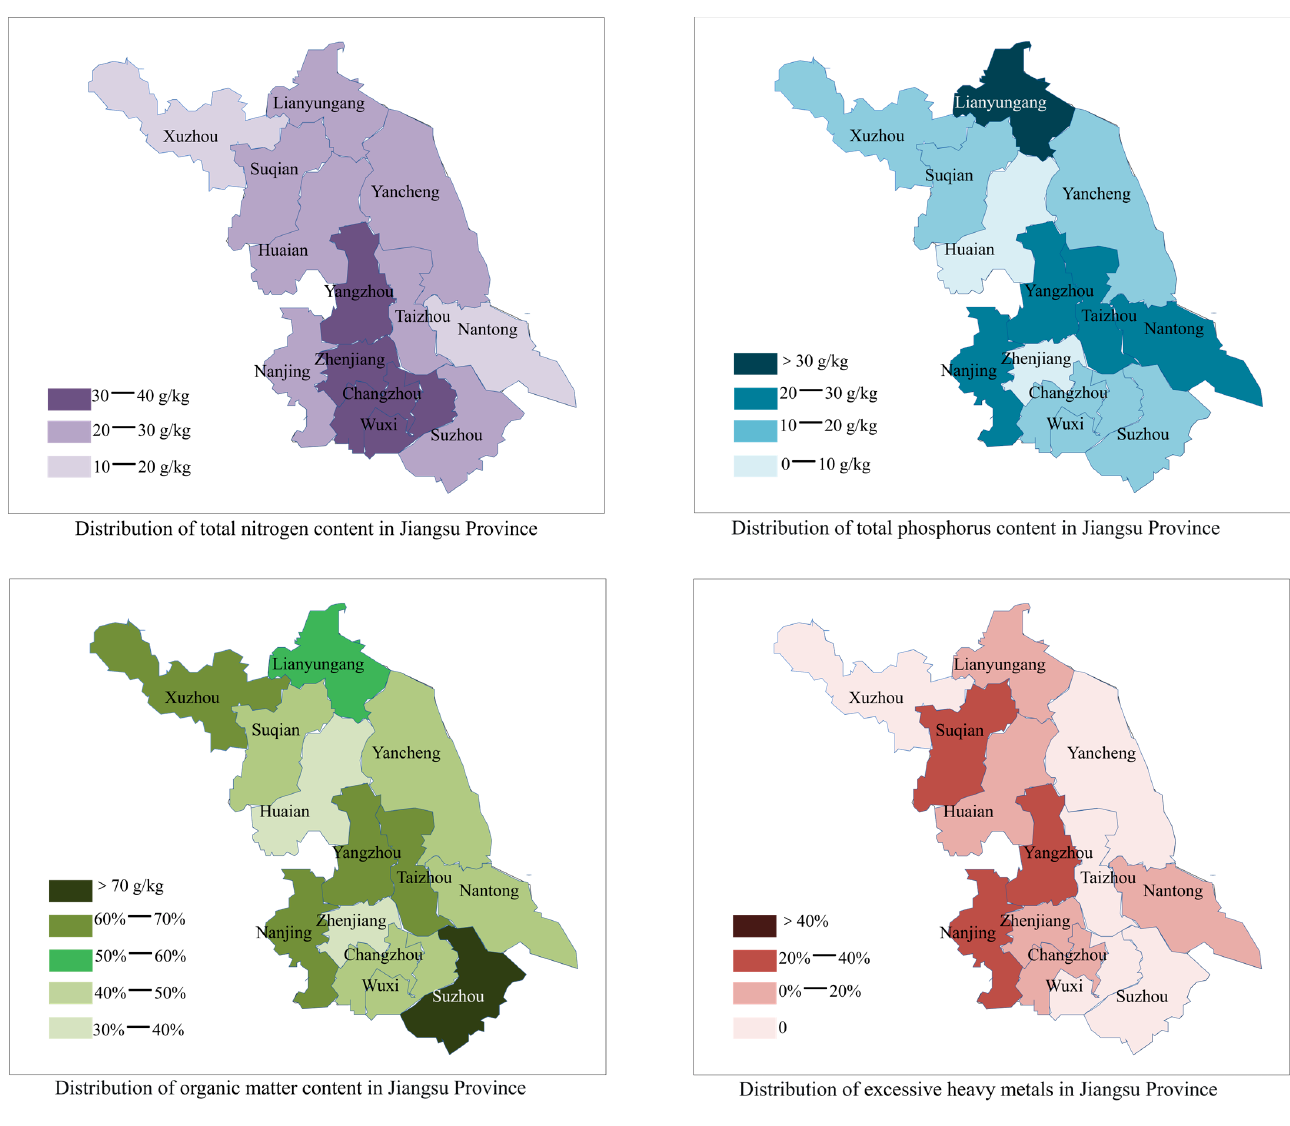
Figure 2. Geographical distribution of total nitrogen, total phosphorus, organic matter and heavy metal exceedances in sewage sludge in Jiangsu Province. Table 3. Pollutant content in different regions in Jiangsu Province.